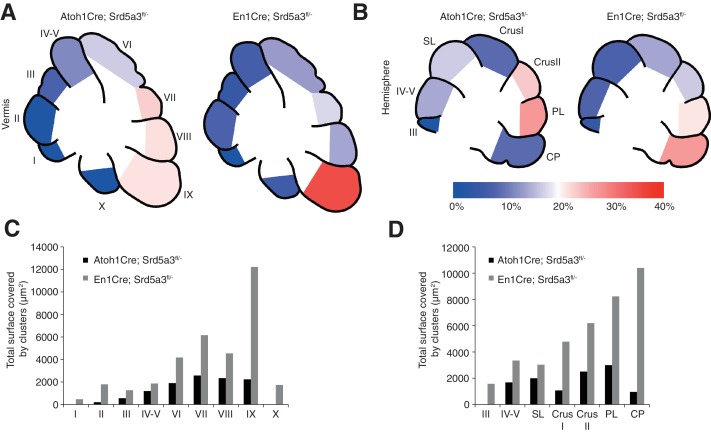
Cerebellar granule cell ectopias quantification.(A) Graphical representation of the granule cells ectopias expressed as a percentage of ectopia surface per lobule at the level of the vermis and (B) the hemispheres for Atoh1-Cre and En1-Cre mice. (C) Quantification of the surface occupied by ectopic granule cell clusters per lobule at the vermis and (D) the hemispheres in both Atoh1-Cre and En1-Cre mice. Two mice were quantified per region and genotype. SL, Simple lobule; PL, Paramedian lobule; CP, Copula of the pyramidis.